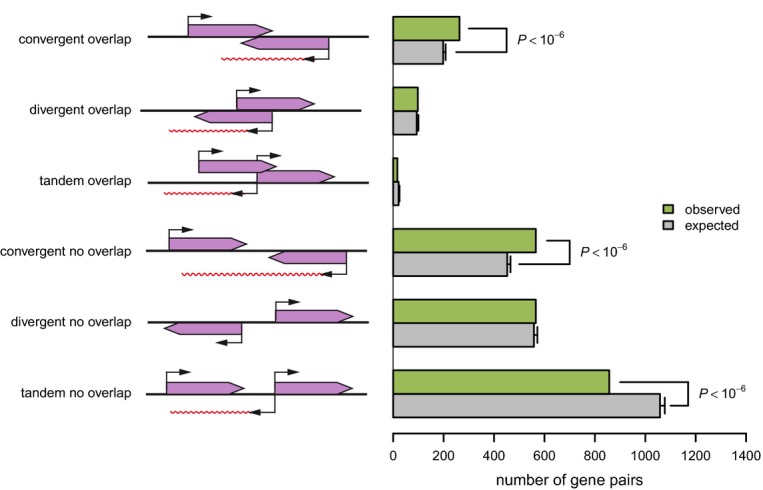
Organization of coding genes whose antisense expression is linked to the
swc5 locusThe organization of gene pairs in the genome is either convergent, divergent, or in tandem and
overlapping or not. However, the distinction between overlapping and non-overlapping genes is
questionable in Schizosaccharomyces pombe, because of imprecise definition of the
untranslated regions (UTRs). Scheme on the left shows geometry of gene pair orientations and the
potential antisense RNA (represented in red wavy lines). The number of swc5 aseQTL
targets falling into each category is shown (green; observed). We used an empirical distribution
based on 1,000,000 random assignments of antisense swc5 targets (gray; expected),
to test for enrichment or depletion of each category (*P <
10−6). The depletion of tandem gene pairs is due to the non-random organization of
the S. pombe genome (Supplementary Information, Supplementary Fig S17). Error bars
indicate standard deviation over 1,000,000 permutations.